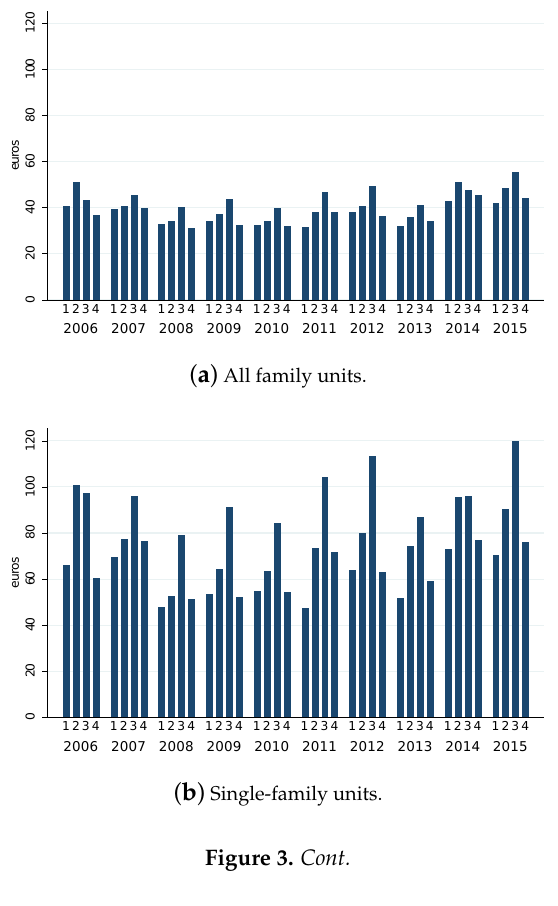
( b ) Single-family units. Figure 3.